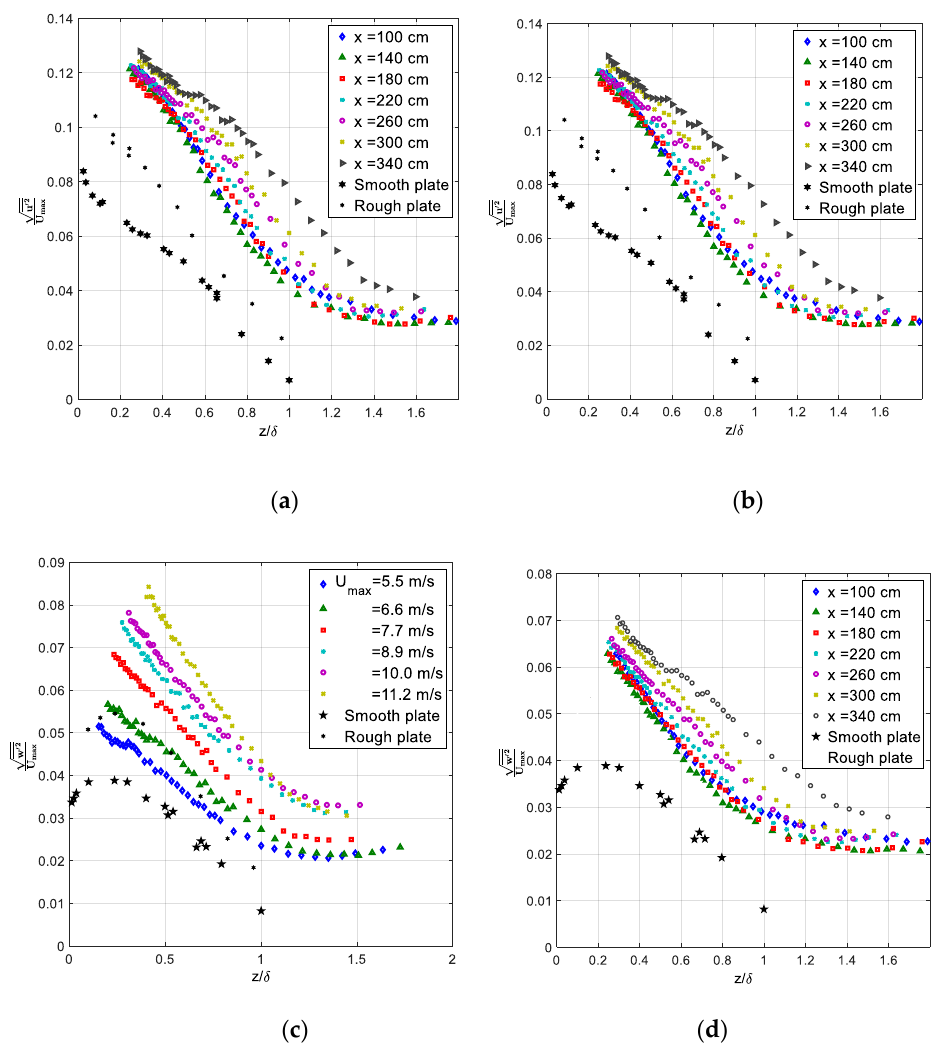
Figure 3. The vertical profile of the relative intensity of velocity fluctuations: ( a ) longitudinal u’ : for various wind velocities at fetch x = 300 cm; ( b ) u’ for various fetches x and U max = 7.7 m/s; ( c ) as in (a) for vertical velocity fluctuations w’; ( d ) as in (b) for w’. The results of Klebanoff [72] in a turbulent boundary layer over a flat plate, and of Corssin and Kistler [73] for longitudinal velocity fluctuations over rough and smooth plates are plotted as well.